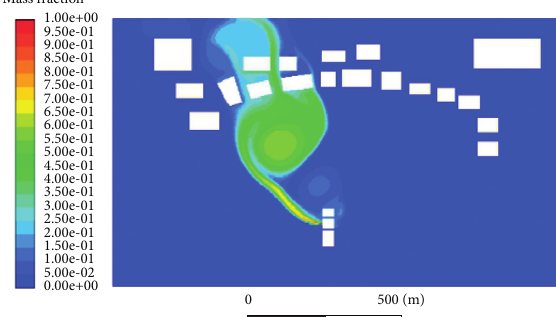
Figure 18: Radionuclide distribution rotating 180 ° clockwise at the eastern break.